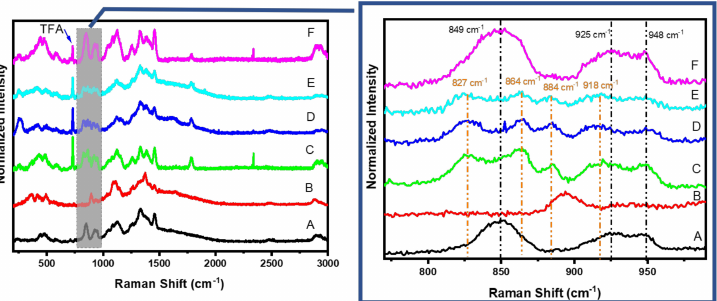
Figure 4. Raman spectra of precursors and di ff erent Chi:HPCD fibers: ( A ) HPCD, ( B ) pristine chitosan, ( C ) as-spun Chi:HPCD 2:50 fiber, ( D ) as-spun Chi:HPCD 2:20 fiber, ( E ) Chi:HPCD 2:50 fiber after 3 days and ( F ) Chi:HPCD 2:50 fiber after 3 months. The expanded region ( Right ) cover the region between 770 and 990 cm − 1